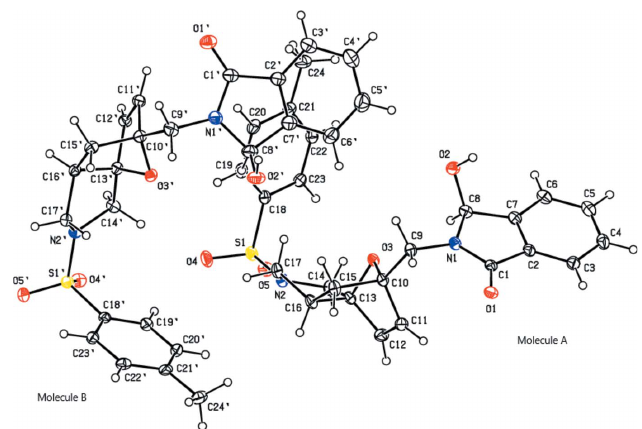
Figure 2 View of the two independent molecules, A and B , in the asymmetric unit of the title compound 3 , with displacement ellipsoids for the non- hydrogen atoms drawn at the 30% probability level.